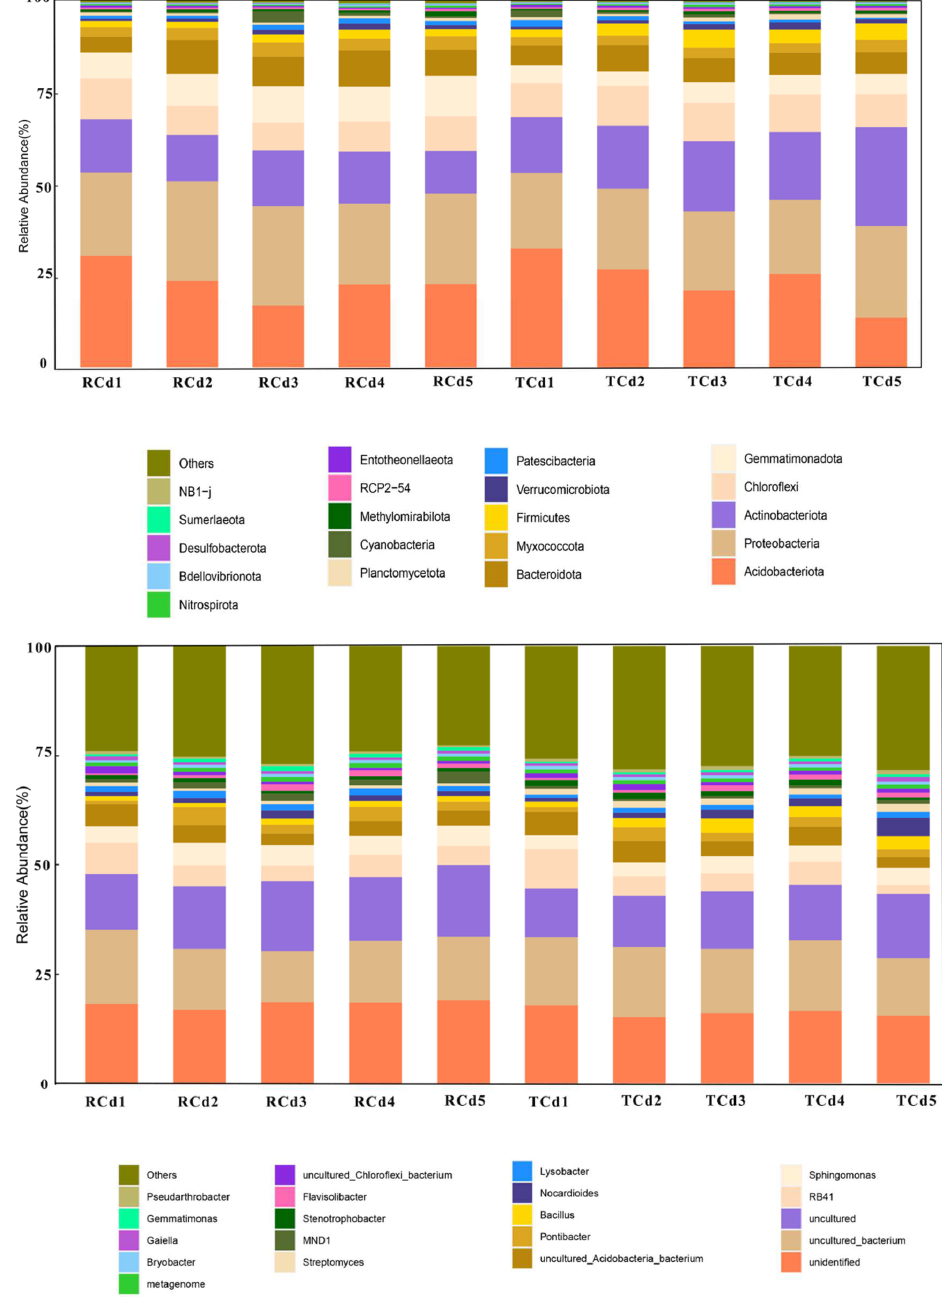
Figure 2. Histograms of the relative abundances of bacterial communities in the rhizosphere soil at the phylum ( top ) and genus ( bottom ) levels.